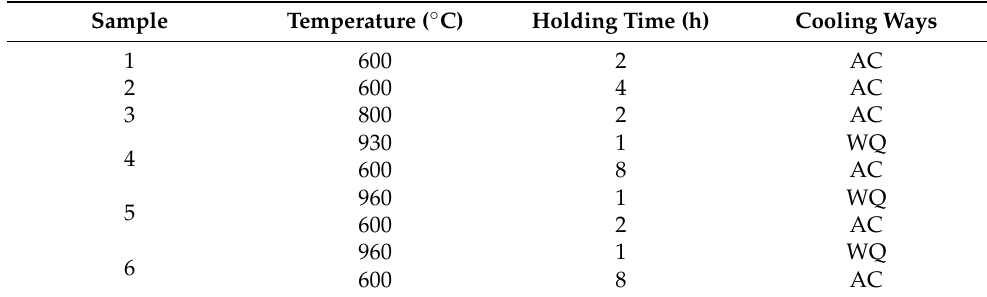
Table 2. Heat treatment methods of SLM